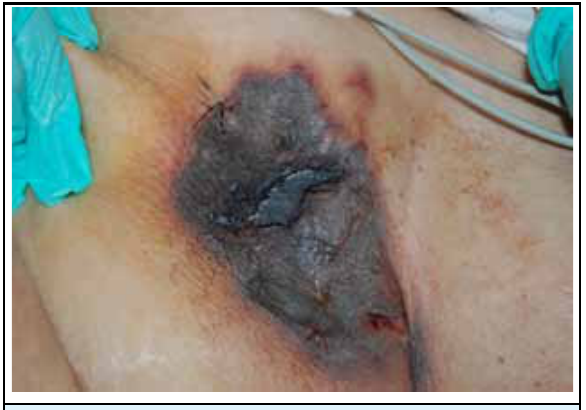
Figure 1. showing warfarin induced skin necrosis under the left infra mammary region